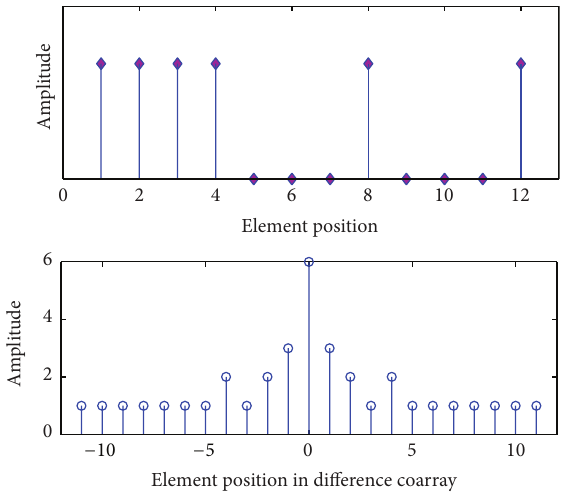
Figure 1: Illustration of a two-level nested-array with 𝑁 1 = 3 and = 3 . 𝑁 2